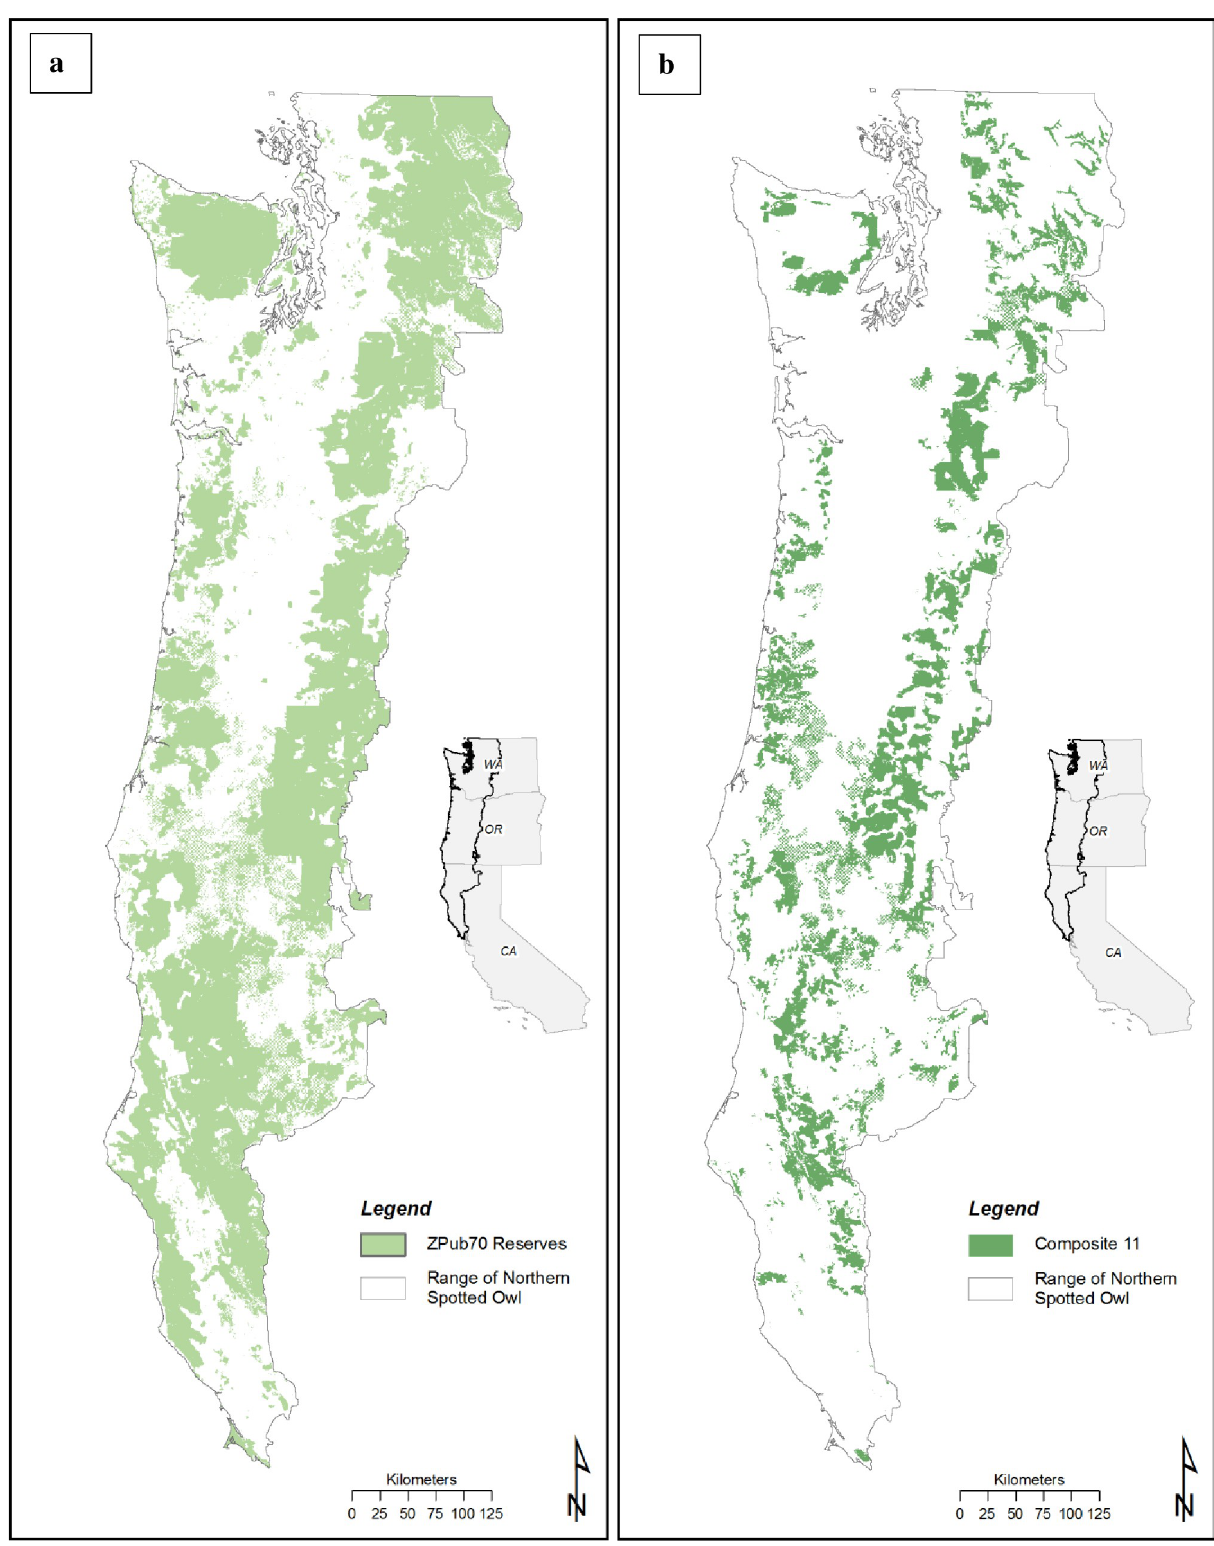
Fig 9. Maps of (a) Composite 11 (Critical Habitat designated in 2012), and (b) The Zonation scenario with 70% of habitat value, with emphasis on public lands. Although Z70PUB was more than twice the size of Composite 11, simulated spotted owl populations performed similarly.